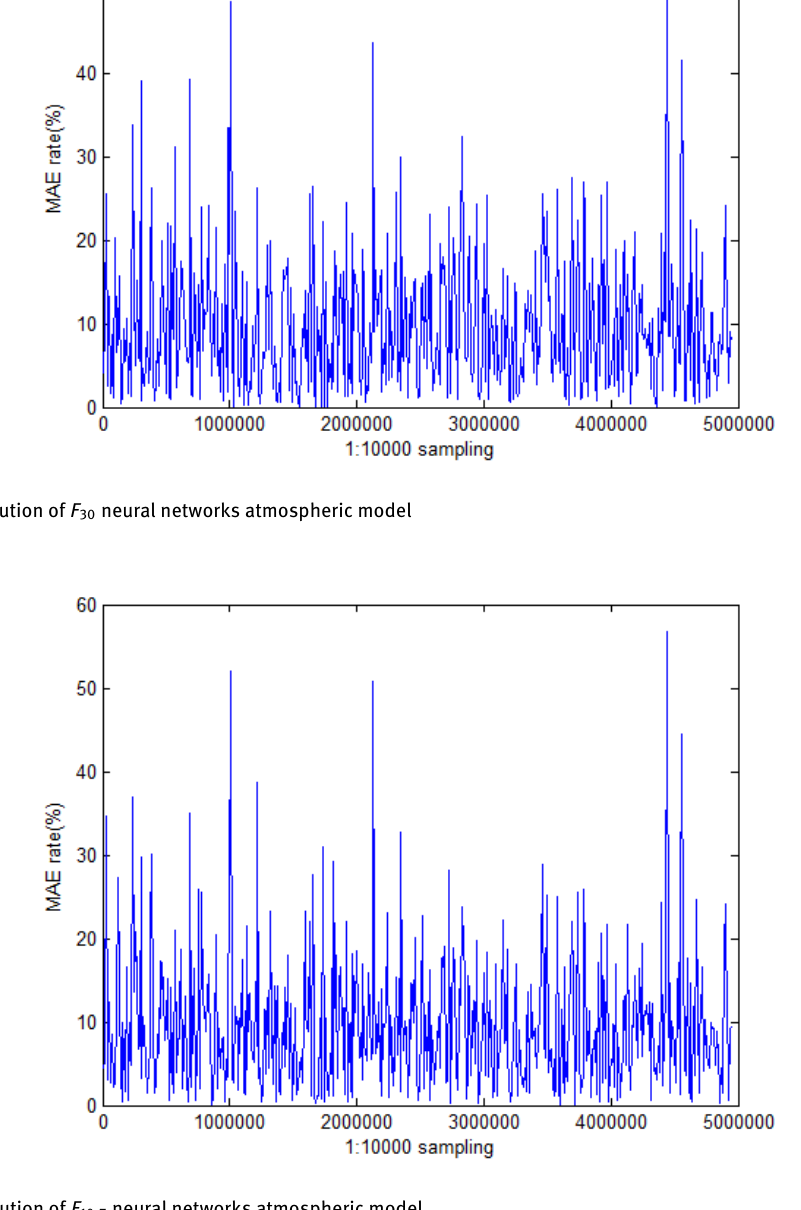
It can be seen from Table 1, Table 2, Table 3, and Figure 8 that in the simulation results of the atmospheric density of random sampling space locations in different years, the performance of the two neural networks models is signifi- cantly better than that of the two traditional atmospheric models. The MAE rates of the neural networks models are about 1/3-1/2 of that of the traditional models. In the two tra-